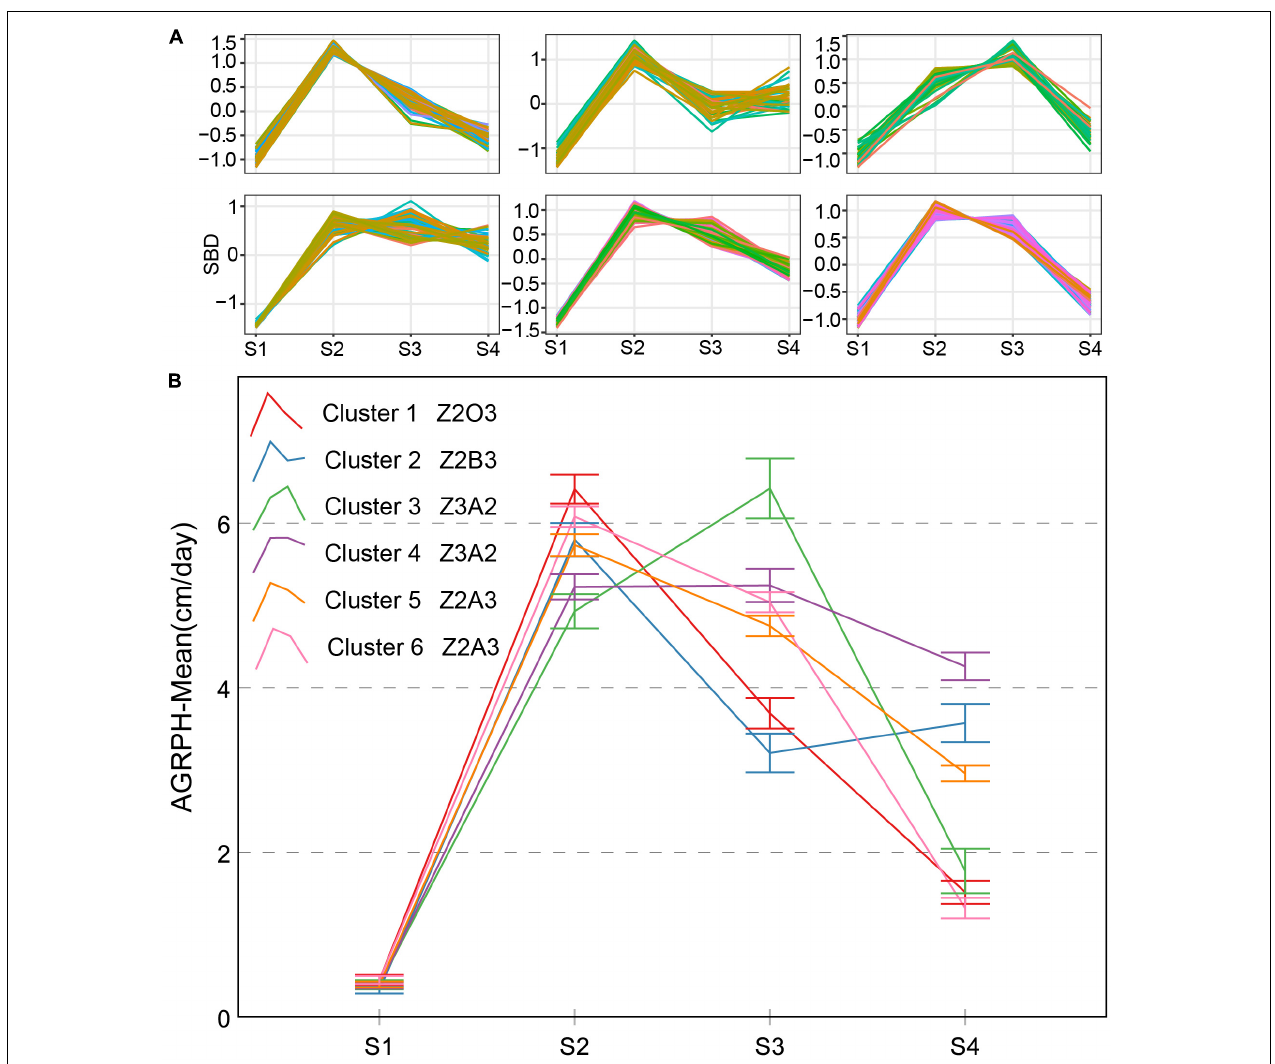
FIGURE 9 | Clustering analysis for AGRPH time series (A) and six clusters and typical curve for AGRPH trait (B) . (A) The horizontal X -axis represents four growth stages, and the vertical Y -axis represents the shape-based distance. (B) The horizontal X -axis represents four growth stages, and the vertical Y -axis represents the mean value of AGRPH at a specific growth stage. In terms of cluster 1–2 and cluster 5–6, zenith point lies at the S2 growth stage and its adjacent point lies at the S3 growth stage. In terms of cluster 3–4, zenith point lies at the S3 growth stage and its adjacent point lies at the S2 growth stage. Typical curves are based on mean values with a 95% confidence interval. AGRPH, average growth rate of plant height; SBD, shape-based